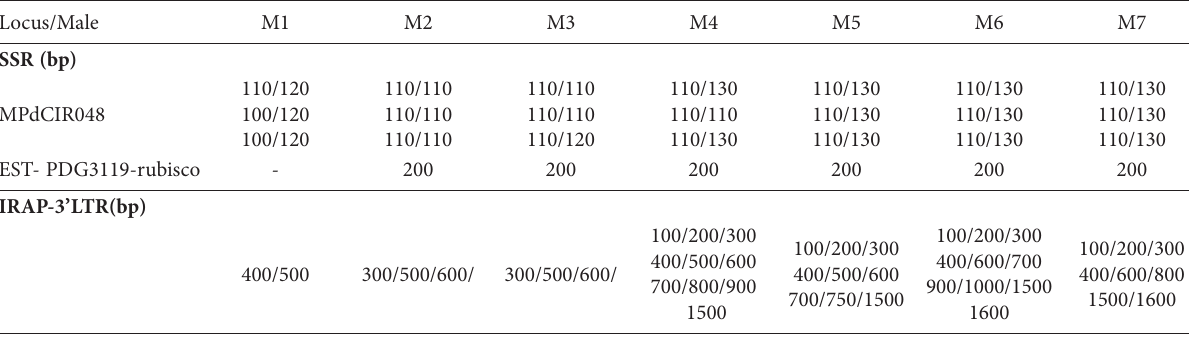
Table 1. Specific alleles in male date palm trees. M1 (SabzParak), M2 (GhannamiSabz ), M3 (Wardi), M4 (GhannamiSorkh 1), M5 (Ghan- namiSorkh 2), M6 (Foreign male1), M7 (Foreign male 2)